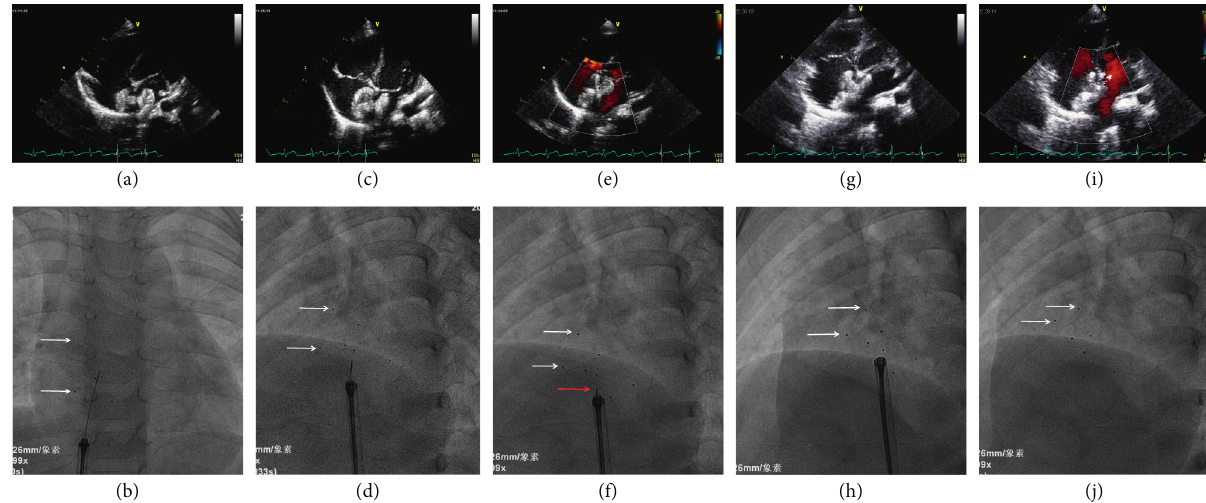
Figure 3: The deployment process of the PLLA device under TTE and fluoroscopic guidance. (a-b) The left disc was unfolded under TTE, and the seven marks were shown on fluoroscopy (white arrows). (c-d) The right disc was fully opened under TTE. White arrows indicated the position of the seven marks. (e-f) The right disc was pushed towards the atrial septum under TTE. Notice the position of the seven marks (white arrows) and the NiTi rod of the locking piece (red arrow). (g-h) The position and shape of the device were evaluated by TTE, and the NiTi rod was detached from the device on fluoroscopy. White arrows indicated the seven marks. (i-j) After the device was released, the final position and shape of the device were evaluated by TTE and fluoroscopy. White arrows indicated the seven